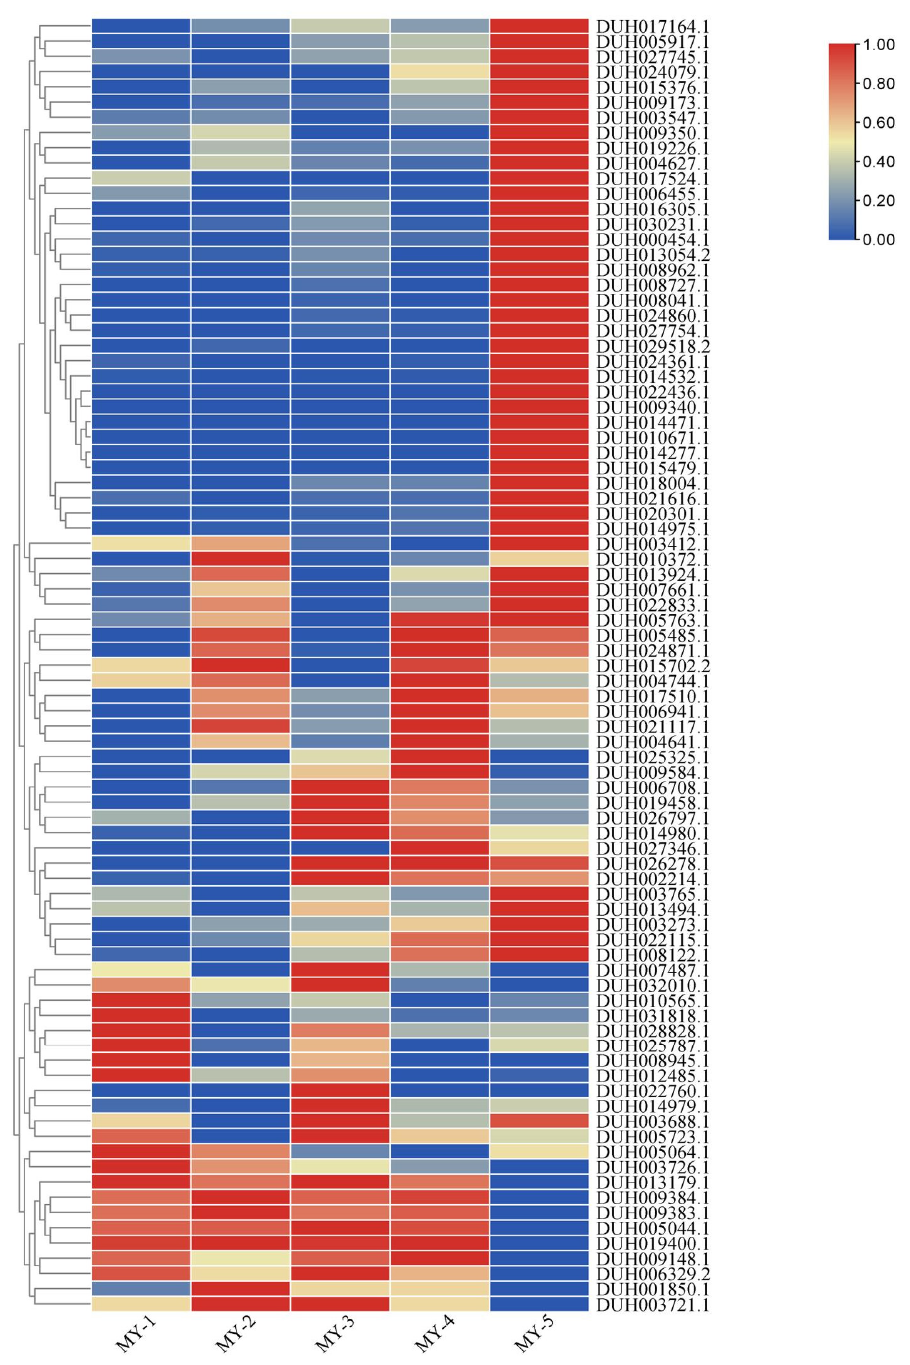
Figure 8. Expression heat maps of 86 R2R3-MYB genes in different samples of R. delavayi : MY-1, spotted petals; MY-2, unspotted petals; MY-3, spotted throat; MY-4, unspotted throat; MY-5, branchlet cortex. The genes on the right indicate the differentially expressed R2R3-MYB in the five types of red samples. Blue rectangles indicate low expression levels, whereas red rectangles indicate high expression levels. Generated hierarchical clustering tree maps and heat maps based on log 2 values of